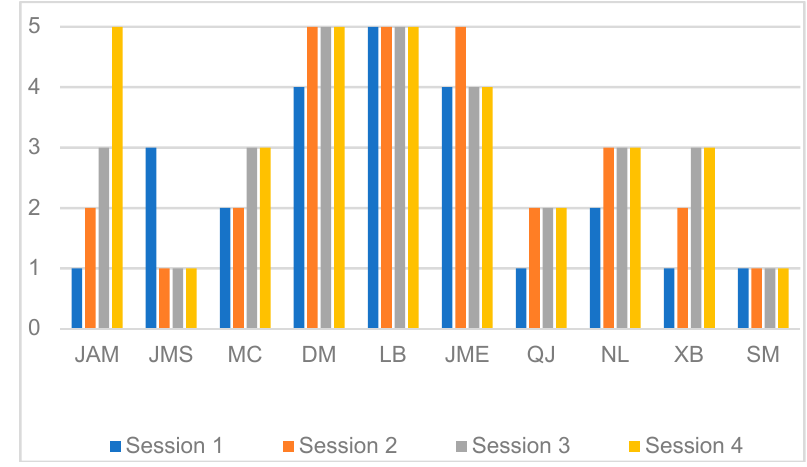
Figure 1. Indicators of degree of motivation (4–5: High; 3: Intermediate; 2–1: Low) for each session of each player.